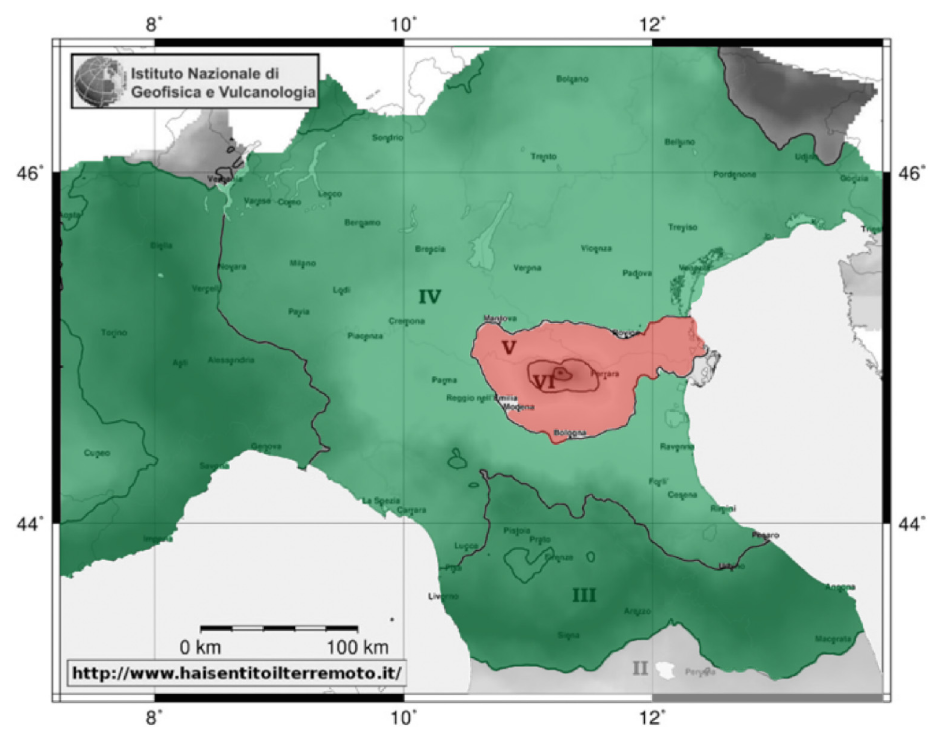
Figure 1. A detail of the map showing the red, green, and white zones.